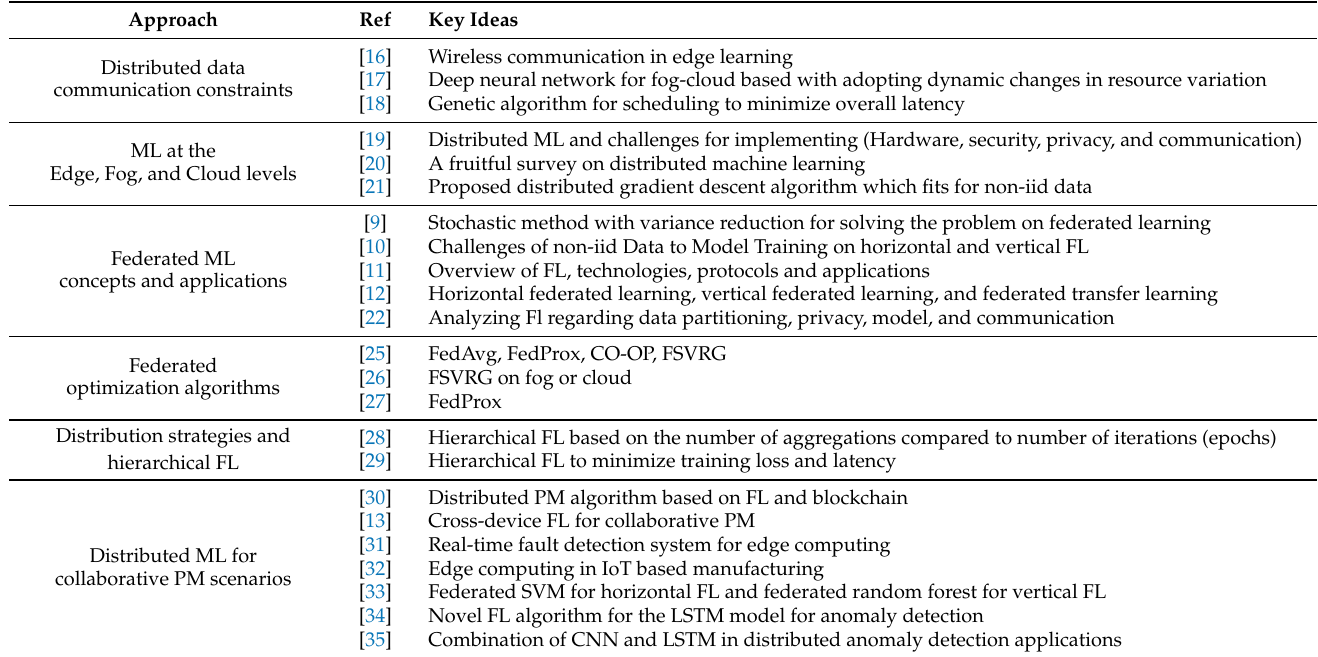
Table 1. Summary of the related